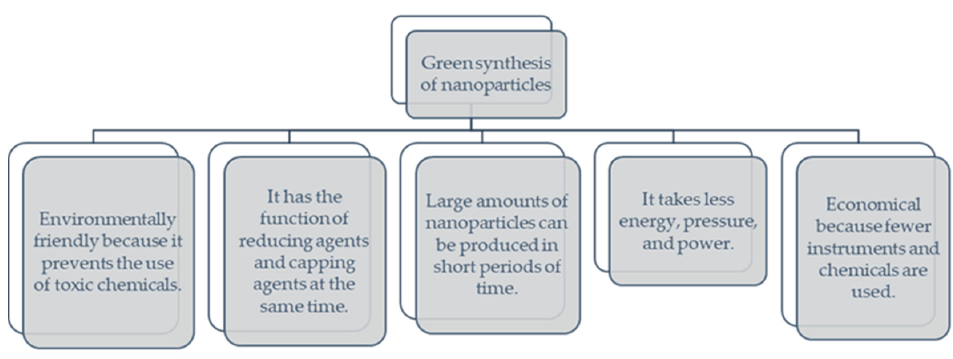
Figure 2. Advantages of green synthesis of nanoparticles, adopted from [20].